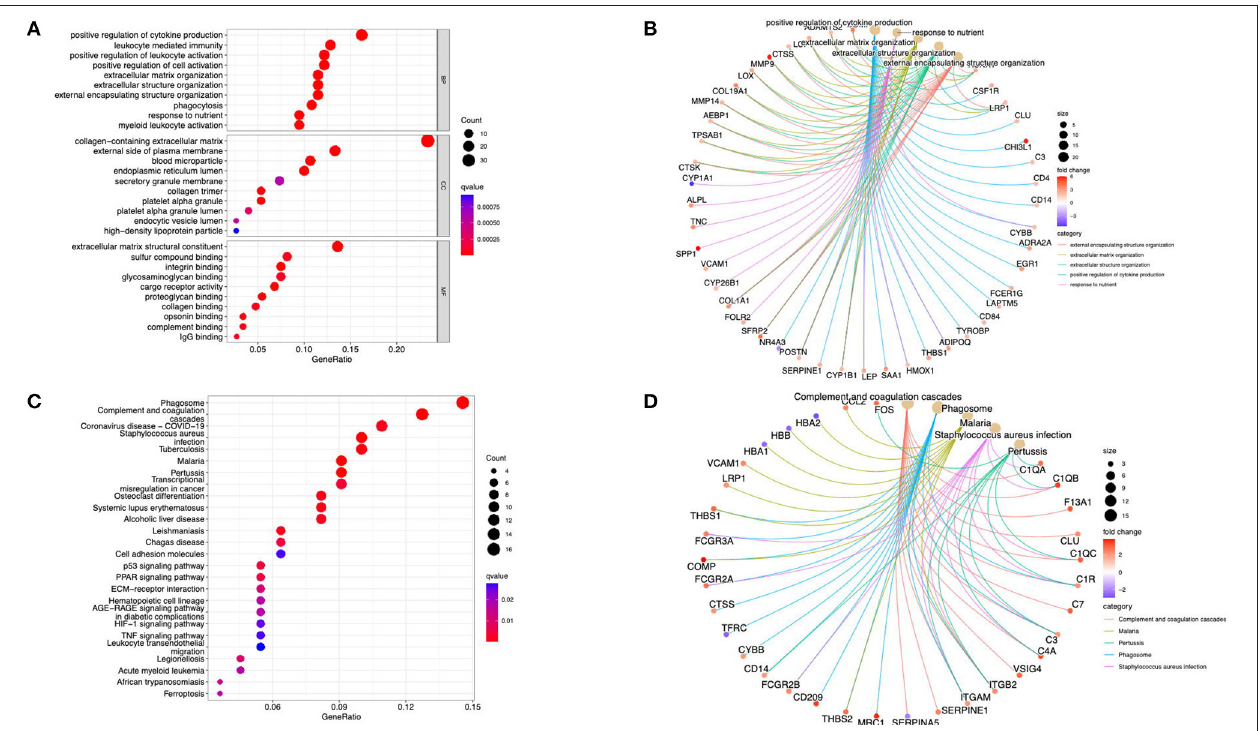
FIGURE 2 | Functional enrichment analysis of the DEGs. (A) The GO terms in biological process, cellular component, and molecular function were performed for functional enrichment clustering analysis. (B) The cent plot of the GO analysis shows the pathway-gene network. (C) The KEGG pathway analysis was performed of DEGs. (D) The cent plot of the KEGG analysis shows the pathway-gene network. DEG, differentially expressed genes; GO, gene ontology (GO); KEGG, Kyoto Encyclopedia of Genes and